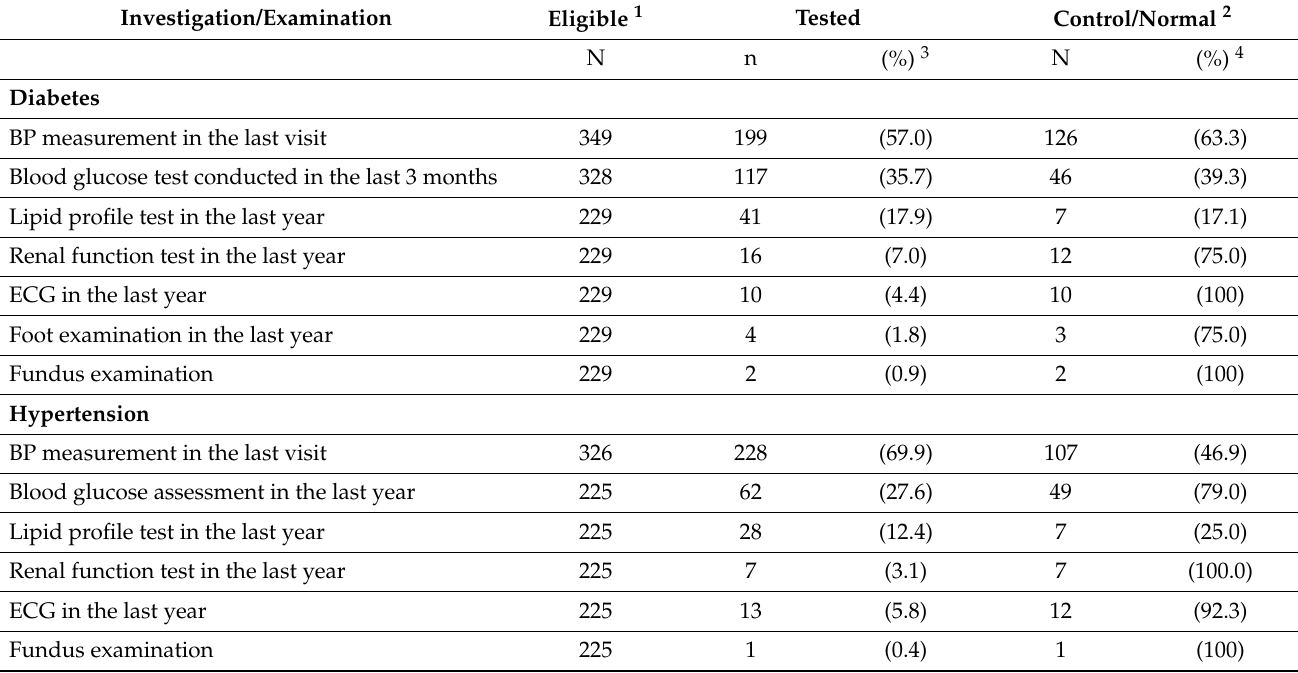
Table 3. The percentage of individuals with diabetes and/or hypertension screened for complications as per the guidelines and having the values of screened parameters under control in the nine selected PMCIs supported by the PSSP of Sri Lanka, June